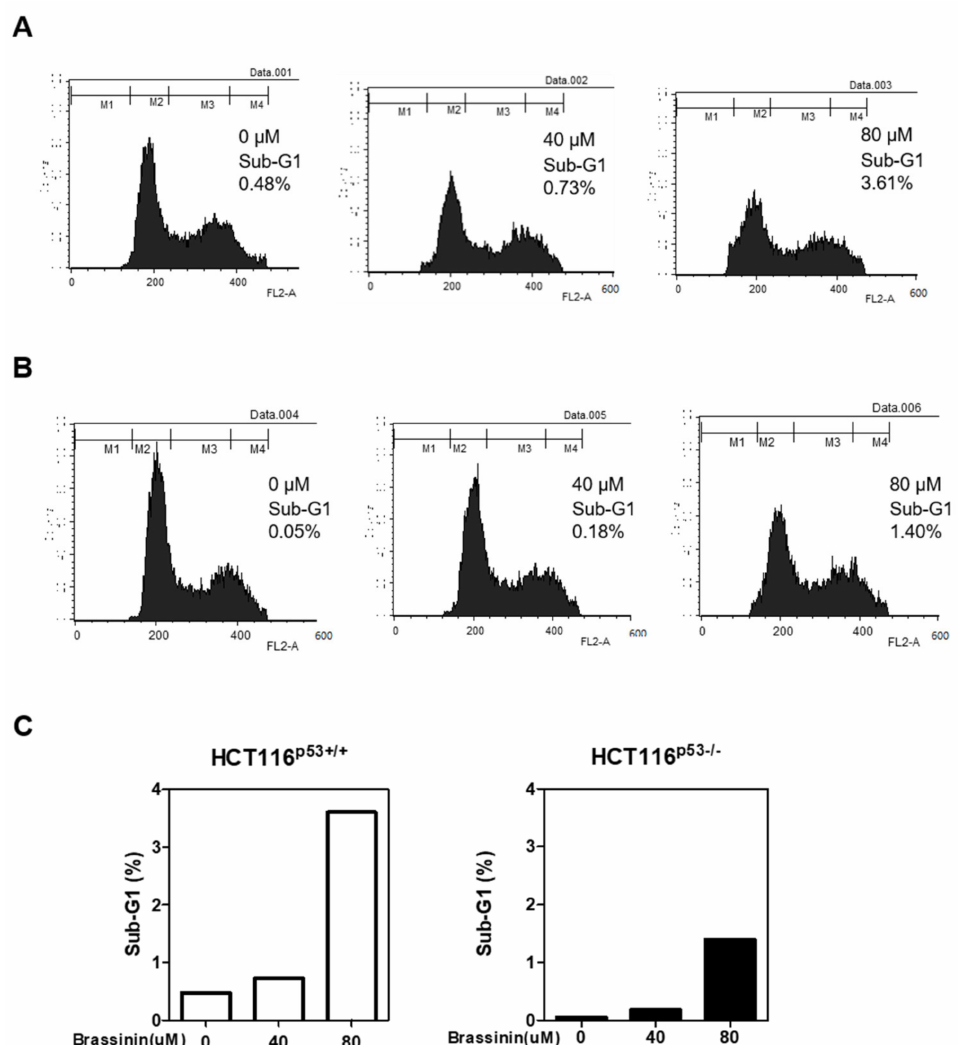
Figure 5. Brassinin increases the sub-G 1 population partially p53-dependent manner. ( A – C ) Effect of Brassinin (40 or 80 µ M) on cell cycle distribution in HCT116 p53+/+ and HCT116 p53 − / − cells. Cell cycle analysis was performed after prolidium iodide (PI) staining by flow cytometry system. Bar graphs showed the percentages of DNA contents undergoing sub-G1 and quantification of cell cycle related cancer cells population (%). Cell cycle division was analyzed by